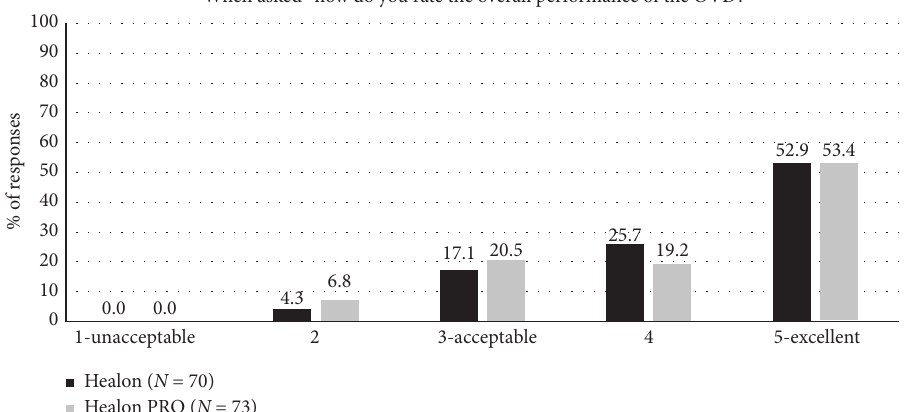
Figure 1: Rate of the overall clinical performance of the Healon PRO OVD (test) and Healon OVD (control), “acceptable” having a response of “3, 4, or 5” in the overall clinical performance of the study viscoelastic.